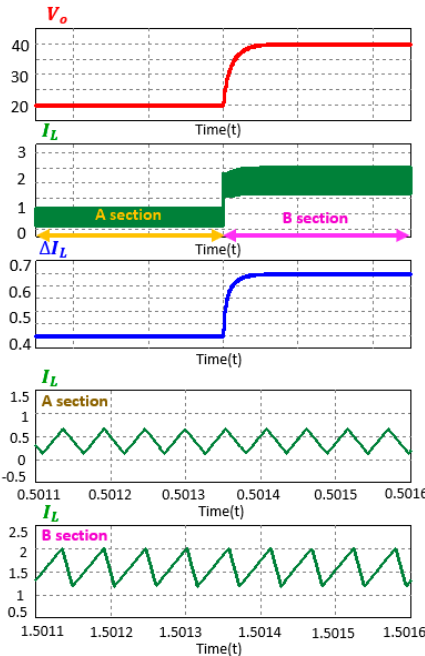
Figure 19. Proposed hybrid current mode controller inductor current response to a rise in output voltage.